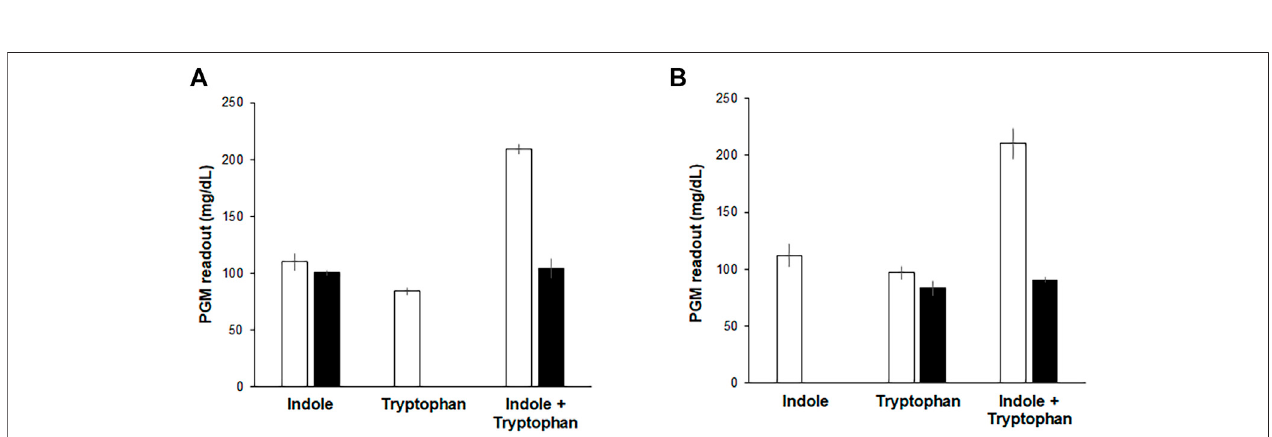
FIGURE 6 | Discriminative measurement of indole and tryptophan. Indole, tryptophan, and their mixture were analyzed by Indole-CCFPS assay using a PGM as a measuringdevice. (A) fortheselectivedetection oftryptophan,themixedsolutionoftryptophan and indole wastreated withLAAO ( fi lled bars), asdescribed inMaterials and Methods. Blank bars represent the results of Indole-CCFPS assays without the LAAO treatment. (B) for the selective detection of indole, the assay mixture was supplemented with AOA ( fi lled bars), as described in Materials and Methods. Blank bars represent the results of Indole-CCFPS assays in the absence of AOA. Measurements were performed in triplicate, and the error bars represent the standard deviations of three independent